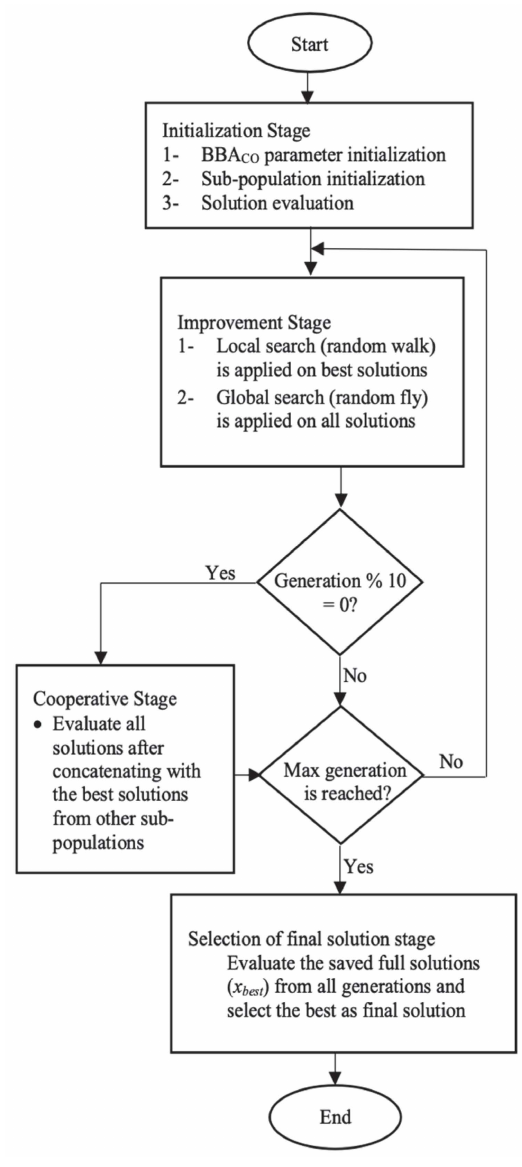
Figure 1. Flowchart of BBA CO